Question: Provide a one-line summary of what is displayed.
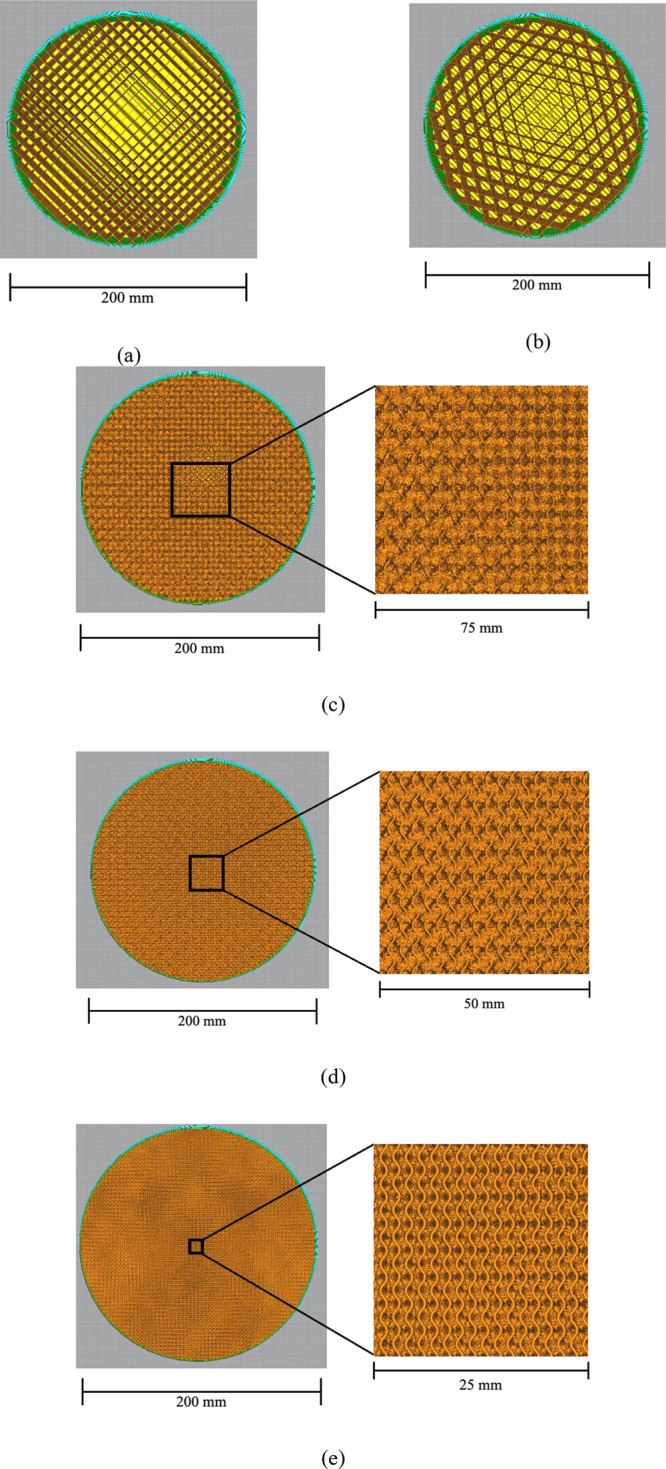
Answer: 3D printing models: (a) grid10%; (b) trihexagonal10%; (c) gyroid10%; (d) gyroid20%; and (e) gyroid30%.